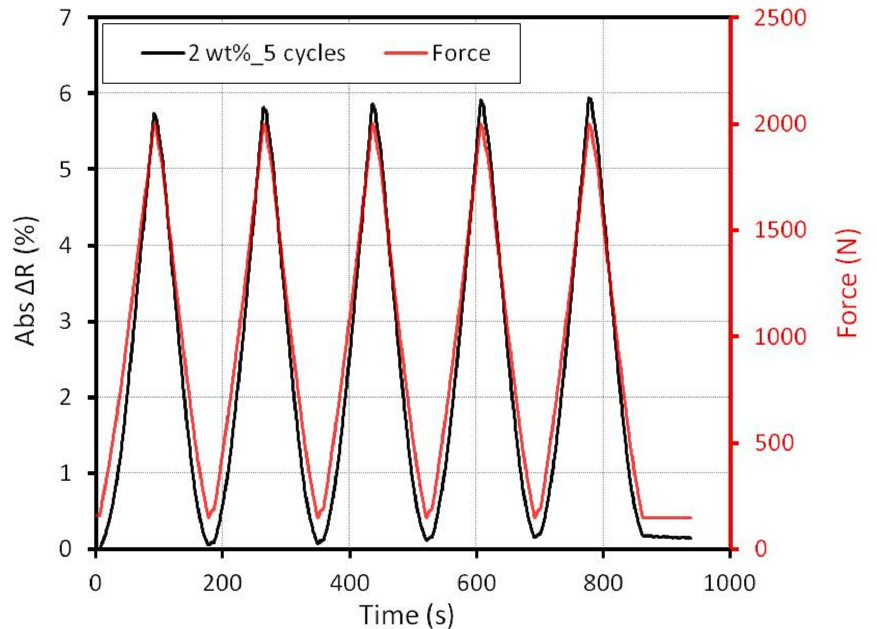
Figure 9. Absolute resistance change at five loading cycles (sample with 2